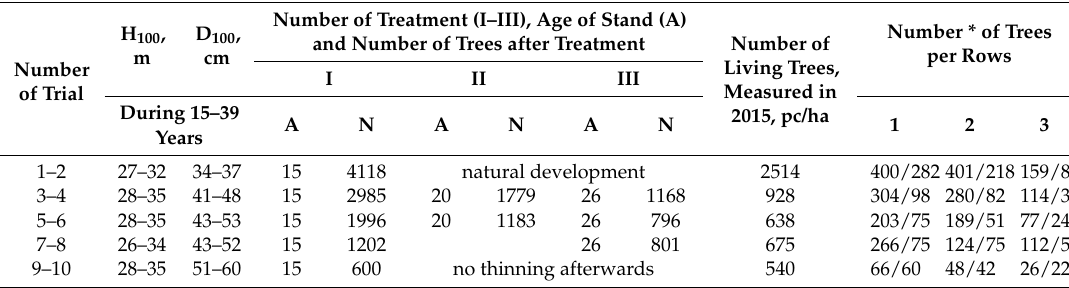
Table 1. The main characteristics of stands and thinning programs applied on trial object (Kretinga, Mikoliškės, No 204).